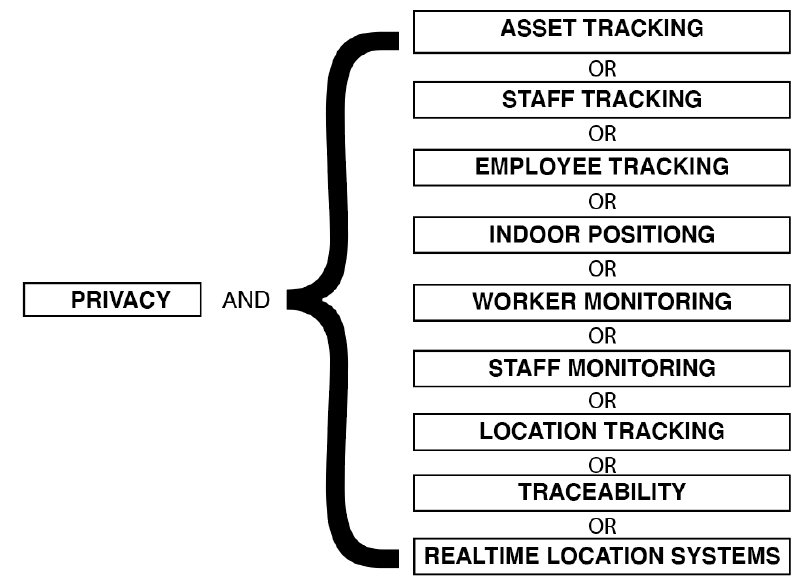
Figure 2. Graphical presentation of the used search